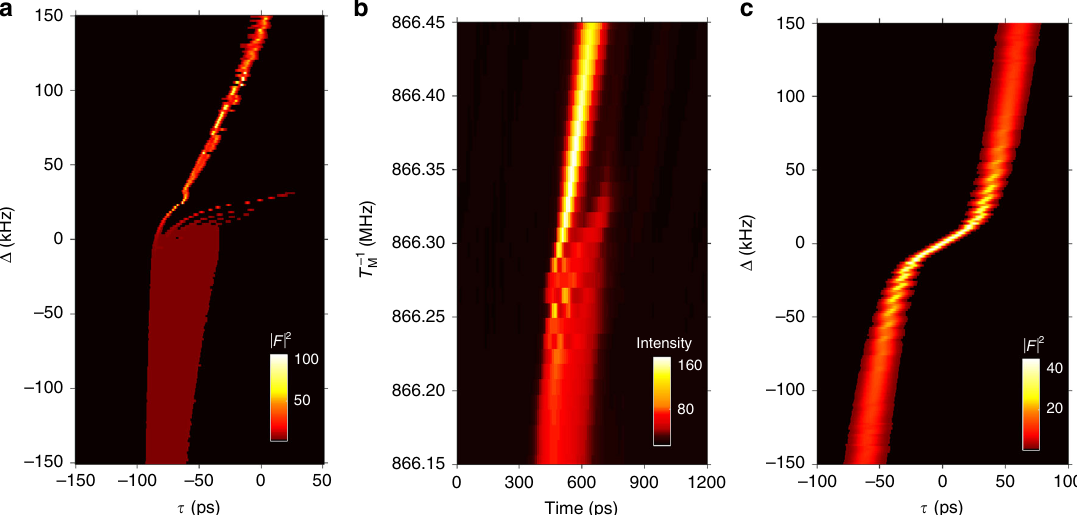
Fig. 3 Dependence of modelocking on the modulation frequency. The long-term intensity of pulses averaged over few modulation periods is displayed. Numerical results from the CME (Eq. (20)) are shown in ( a ) for different values of the modulator detuning Δ ¼ T (cid:4) 1 experimental results in ( b ) for different values of the modulation frequency T (cid:4) 1 theory are shown in ( c ). The CME captures an essential feature of modelocking observed in experiment, namely the asymmetric effect of the detuning which is absent in Haus theory. The parameters used in ( a ) and ( c ) are Ω